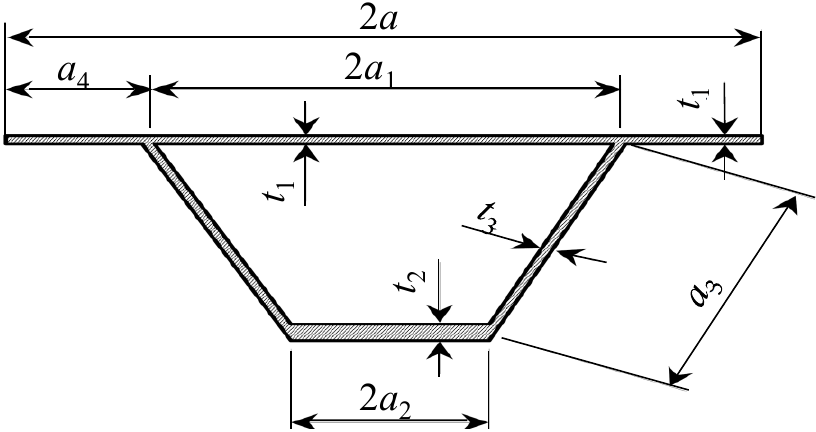
Figure 2. Basic cross-sectional dimensions of a hat profiled shear panel section where: a , overall top flange width; a 1 , internal top flange width; a 2 , internal bottom flange width; a 3 , internal web height; a 4 , external top flange width; t 1 , top flange thickness; t 2 , bottom flange thickness; t 3 , web thickness.